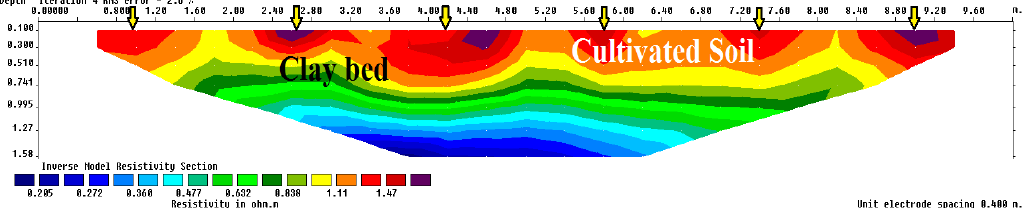
Figure 11. Inverted resistivity models of the ERT data conducted at plot B showing the thickness of its root zone. Yellow arrows are pointing at the locations of the drains.